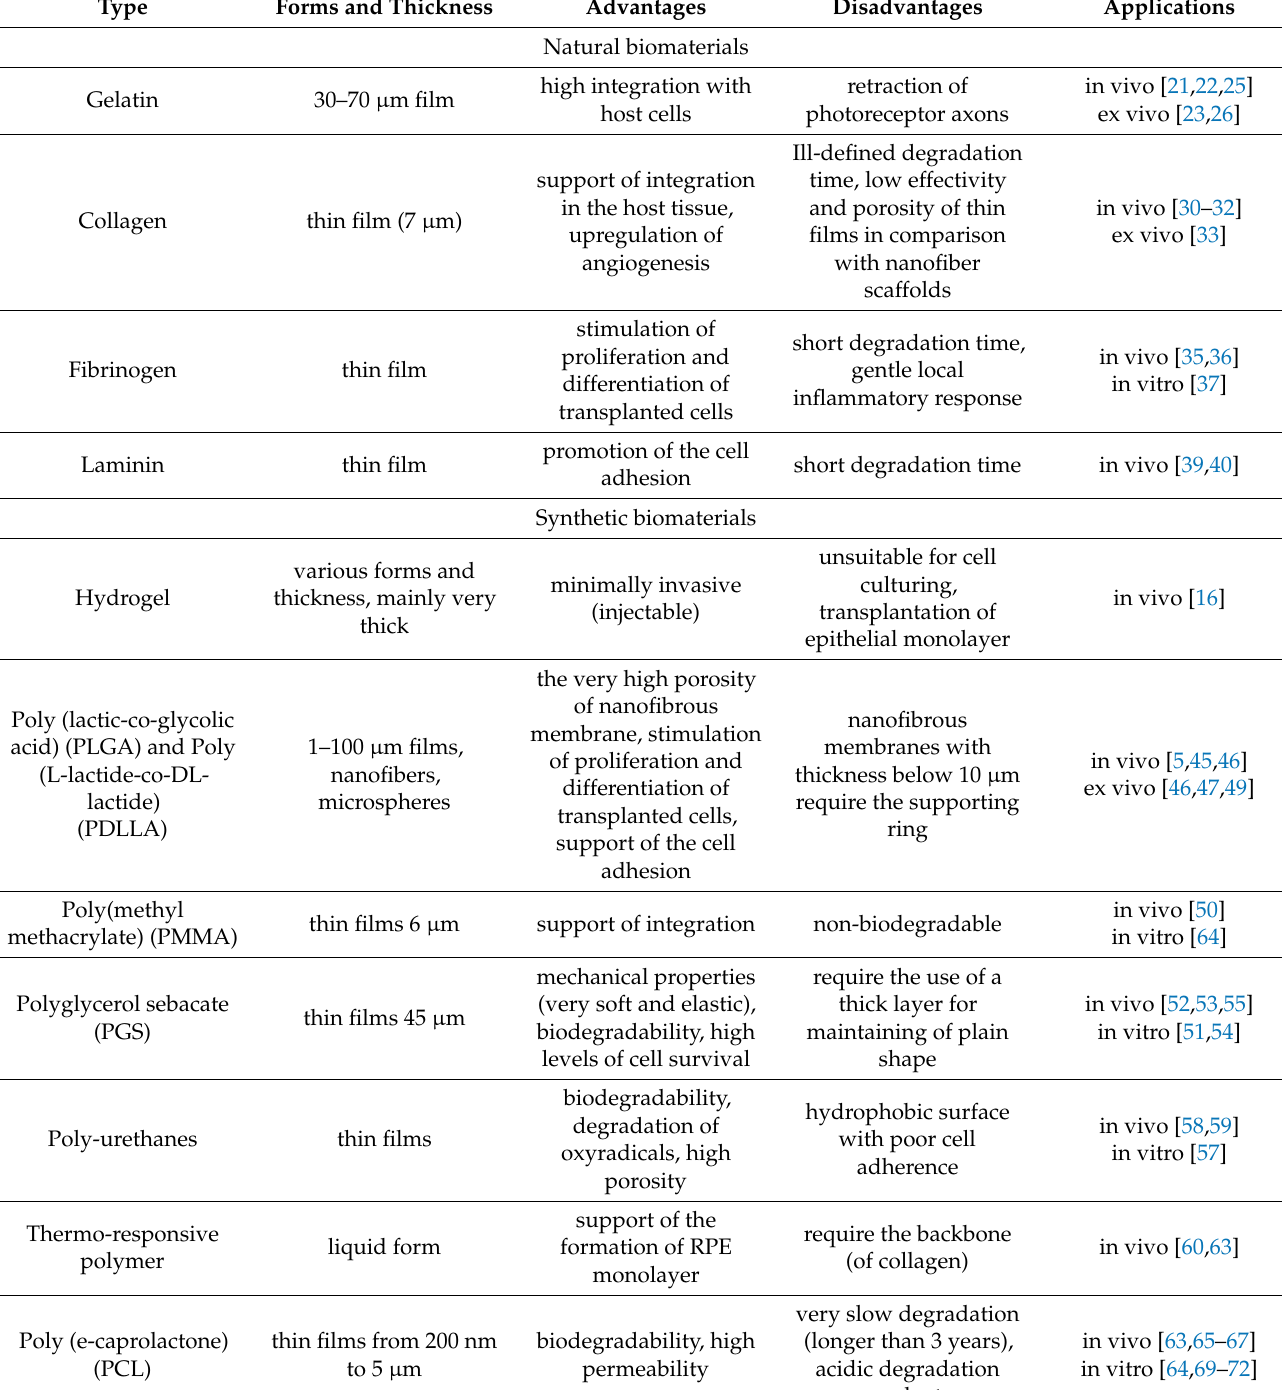
Table 1. Summary selected biomaterials from the biocompatibility and medicinal use point of